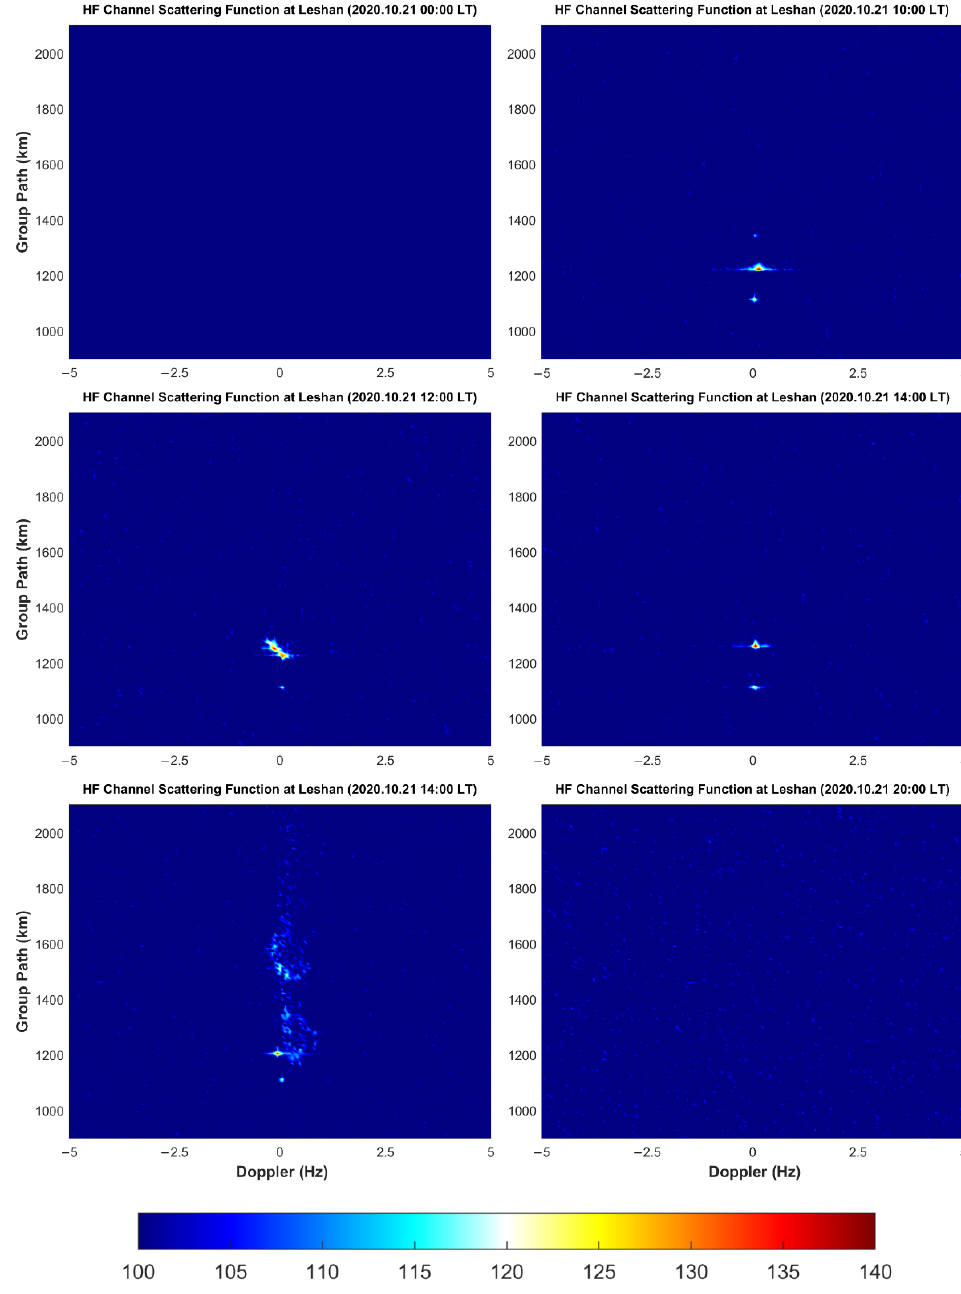
Figure 2. 21 October 2020, data processing results of Leshan station. The redder the color in the figure, the stronger the received signal energy. The color bar only represents the relative size of the value. The time the data were received was 00:00 LT ( upper left ), 10:00 LT ( upper right ), 12:00 LT ( middle left ), 14:00 LT ( middle right ), 16: 00 LT ( lower left ), and 20:00 LT ( lower right ). If elliptic-like bright spots appear in the figure, it means that the receiver can receive signals reflected from the ionosphere. Generally speaking, the elliptic-like bright spot with the smaller ordinate is reflected through the E layer (in which the group paths are about 1100 km), and the elliptic-like bright spot with larger ordinate is reflected through the F layer (in which the group paths are about 1200–1300 km). There is no elliptic-like bright spot in the upper left and lower right panels, which indicates that the Wuhan receiver cannot receive the HF signals transmitted from Leshan station at these two moments (as mentioned above, the signals with a frequency of 10.8 MHz were unable to obtain a good oblique measurement reception effect at